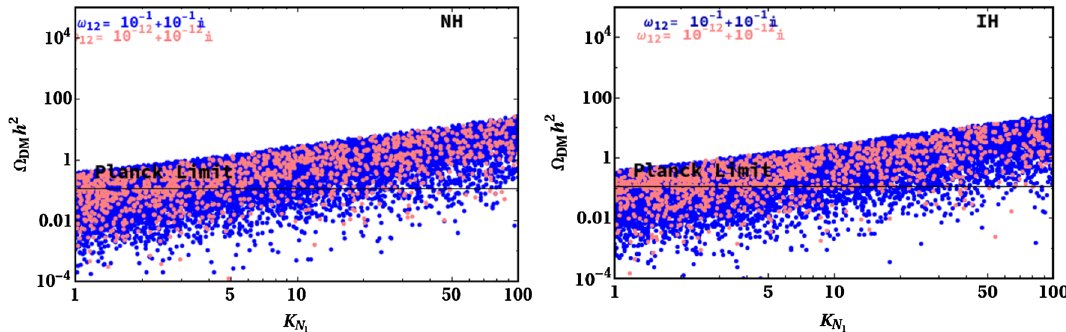
Fig. 8 The plot shows variation of relic abundance w.r.t the decay parameter K N benchmark values of ω 13 = 10 − 3 + 10 − 3 i and ω 23 = 10 − 2 + 10 − 2